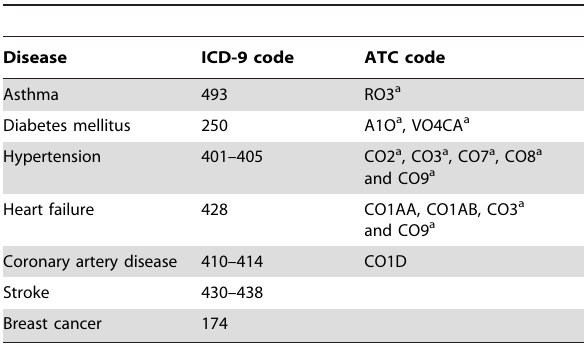
Table 1. The diseases featured in the dataset and their